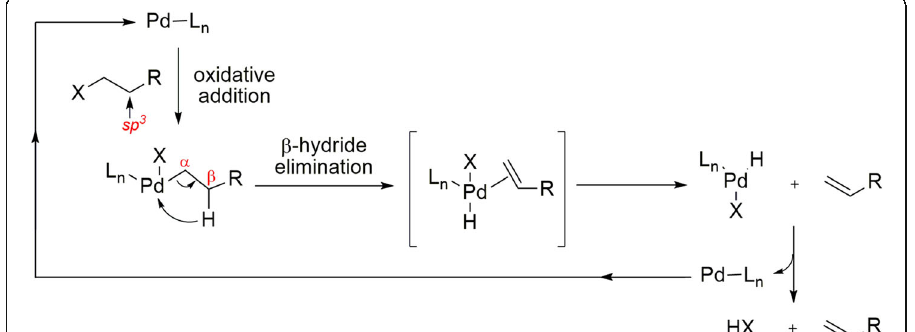
Fig. 14 Representation of β -elimination mechanism